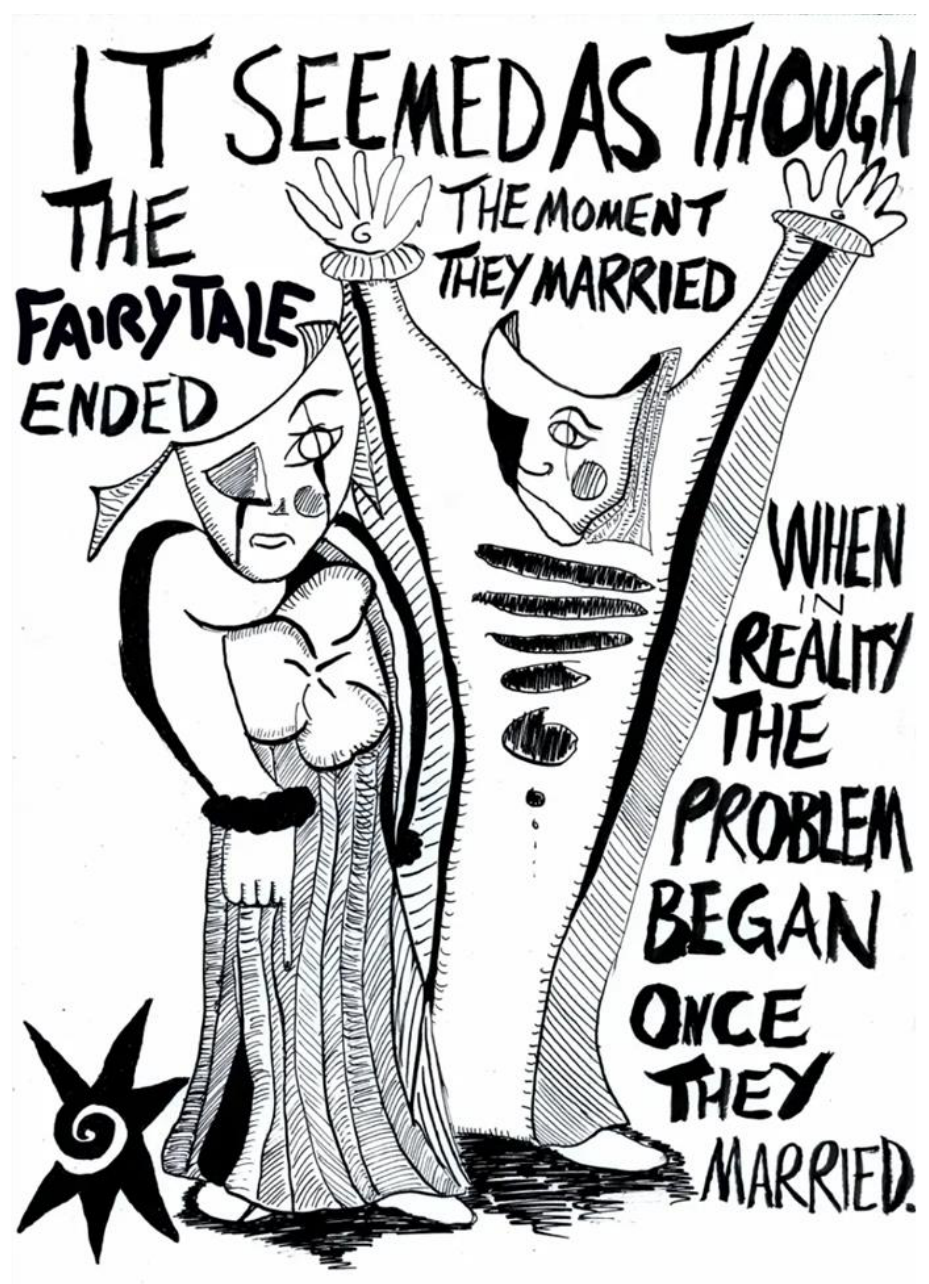
Figure 10: This drawing is inspired by my Abuelito’s painting of two masked theatrical clowns (Sherwood Gonzalez 2019,